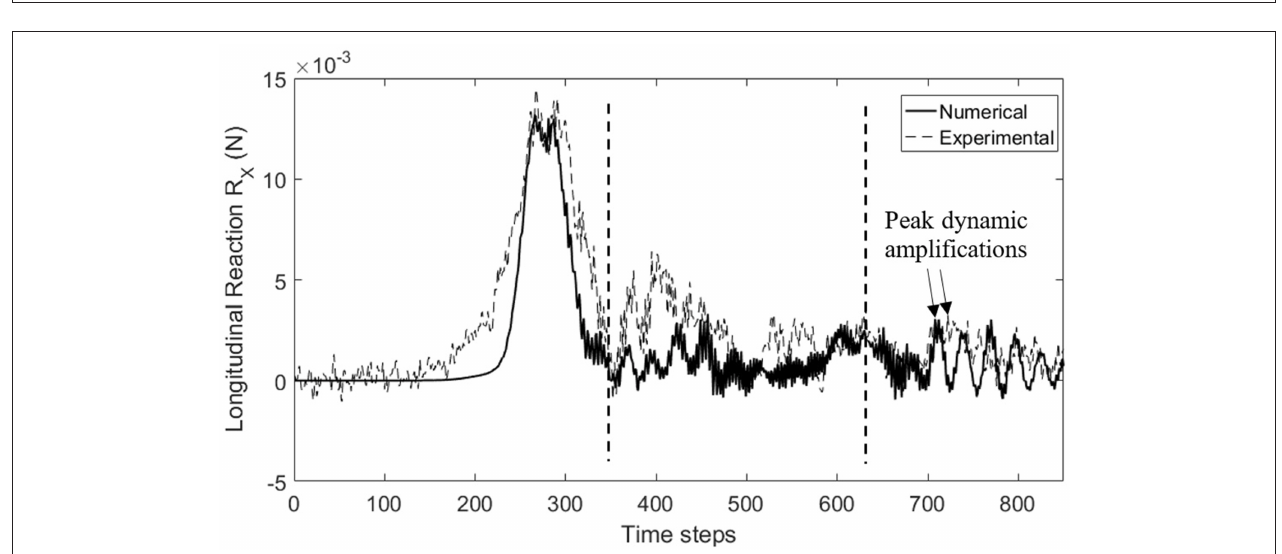
FIGURE 6 | Comparison of longitudinal reaction time histories from numerical and experimental